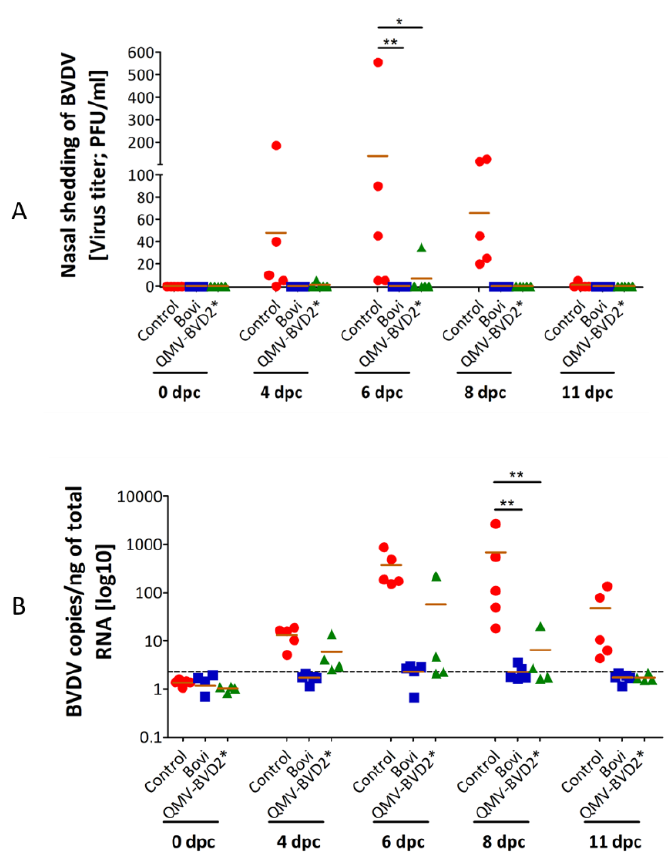
Figure 9. BVDV nasal virus shedding and viremia following challenge with BVDV–2 890 strain. ( A ) Virus isolated from each animal’s nasal swabs following the challenge with BVDV 2 non–cytopathic strain 890 was titrated in MDBK cells by plaque assay as described in the materials methods for the cytopathic strain 125. However, the viral plaques were visualized after 96 h post–inoculation using BVD2–E2–specific mAb and fluorescent–tagged secondary antibody. Shown are the titers of each animal of the three vaccination groups on 0 dpc, 4 dpc, 6 dpc, 8 dpc and 11 dpc. The data represent mean + individual values in each group. Significant differences in nasal shedding of BVDV virus titer were seen between different groups. n = 5 (QMV–BVD2* group contained 4 animals); Two–way ANOVA followed by Bonferroni post–tests to compare replicate means by row; * p < 0.05, ** p < 0.01. Grubb’s test (generalized extreme studentized deviate method) revealed the existence of outlier in BVD–QMV2* group (Animal # 630). On both 4 and 8 dpc, Calf #630 in BVD–QMV2* group was a significant outlier ( p < 0.05) for nasal virus shedding, in comparison to other calves in the same group (Table S4). ( B ) BVDV viremia was assessed by Real–time quantitative RT–PCR using the VetMax–Gold BVDV kit (ThermoFisher, # 4413938) after the challenge with 890. BVDV2 genomic copy numbers were calculated according to CT–values of a standard curve. Shown is the mean copy number of the BVDV genome in one ng total RNA of three independent PCR analyses in duplicates of each animal of the three vaccination groups on 0 dpc, 4 dpc, 6dpc, 8 dpc and 11 dpc. The dotted line separates negative from positive results and is based on the highest copy number detected in samples from 0 dpc (Threshold of 2.32 copies/ng total RNA). The data represent mean + individual values in each group. Significant differences in BVDV genome copies were seen between different groups. n = 5 (QMV–BVD2* group contained 4 animals); Two–way ANOVA followed by Bonferroni post–tests to compare replicate means by row; ** p < 0.01. As above in “A”, according to Grubb’s test–generalized extreme studentized deviate method, on 4, 6 and 8 dpc, Calf # 630 in BVD–QMV2* group was a significant outlier for viremia ( p < 0.05) in comparison to other calves in the group (Table